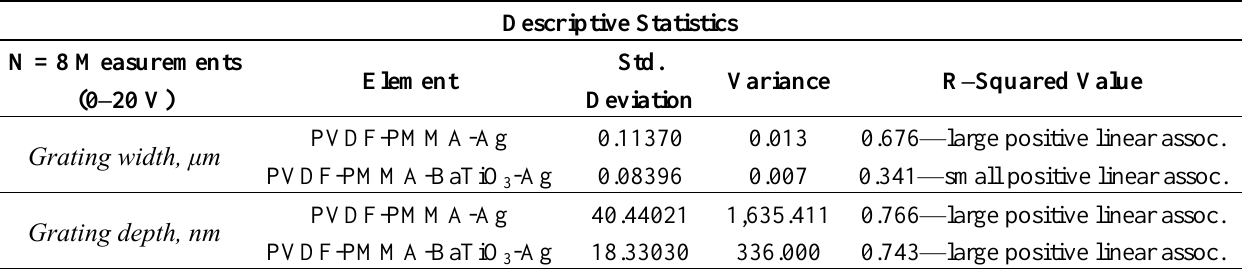
Table 3. Descriptive statistics of the grating geometry dependence on the applied